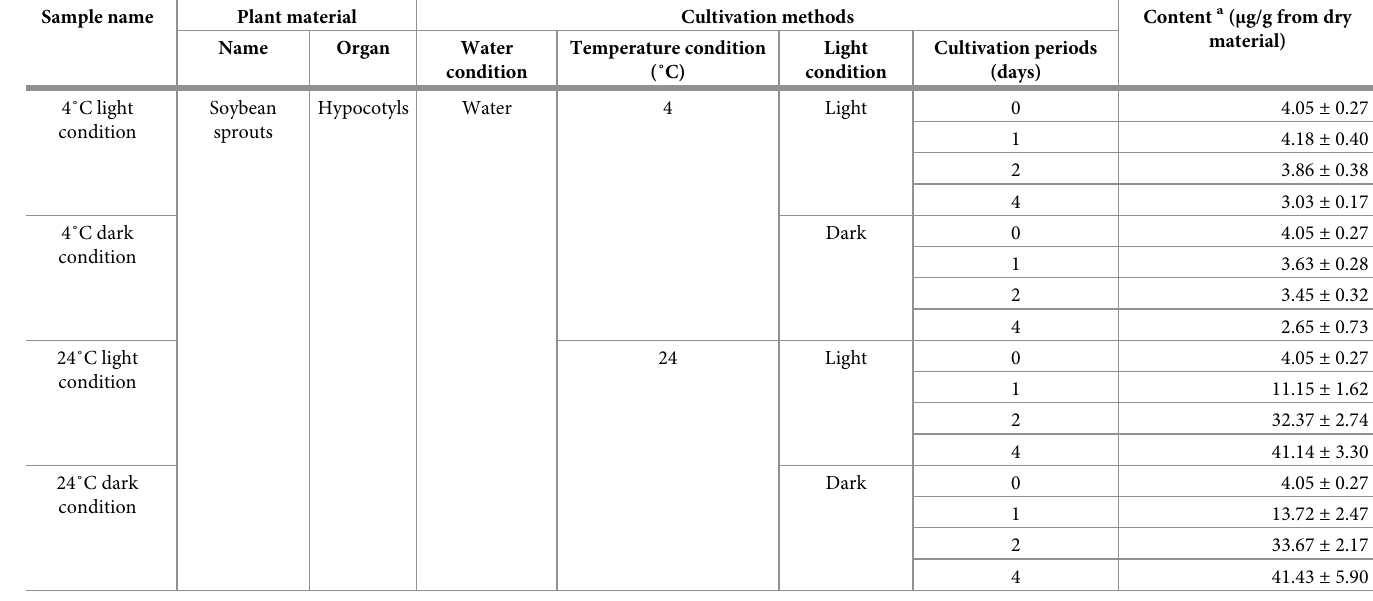
Table 2. Sample details and CM contents of soybean sprout hypocotyls grown under different light (light and dark) and temperature (4˚C and 24˚C) conditions. Sample